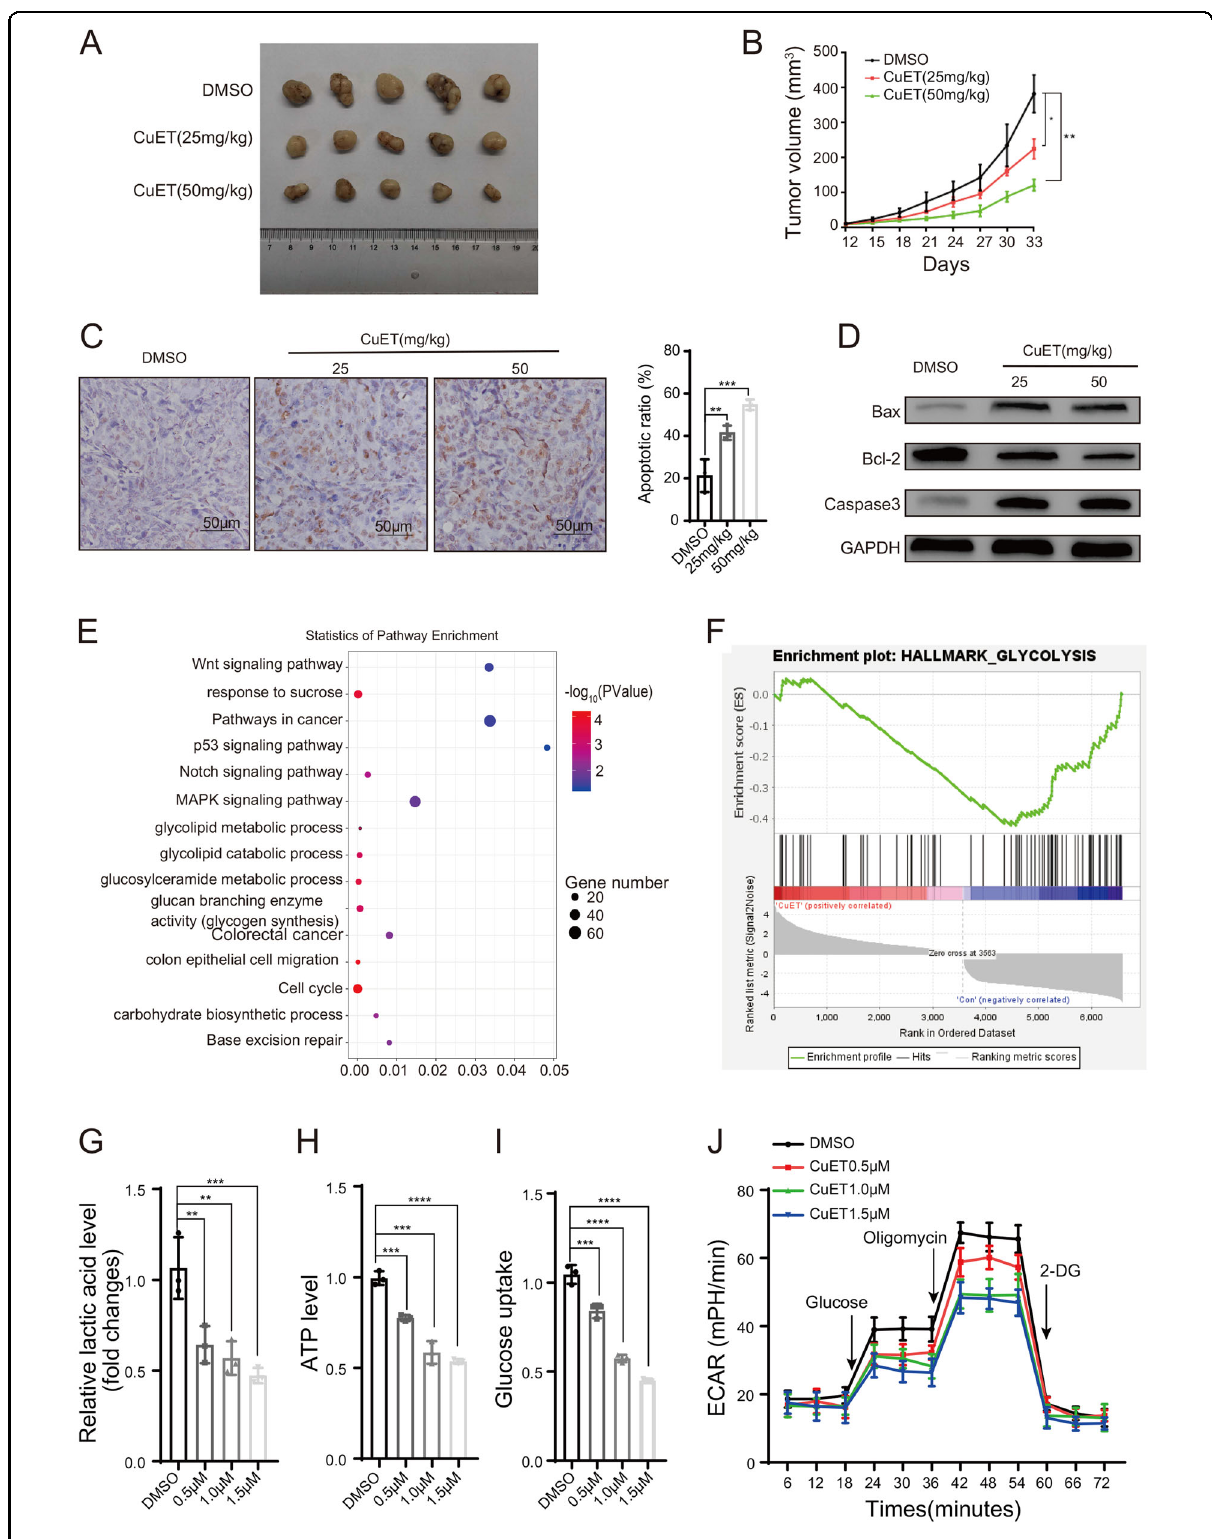
Fig. 2 (See legend on next